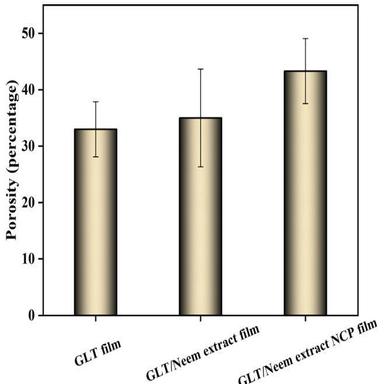
Porosity evaluation of GLT film, GLT/Neem extract film, and GLT/Neem extract NCP film.